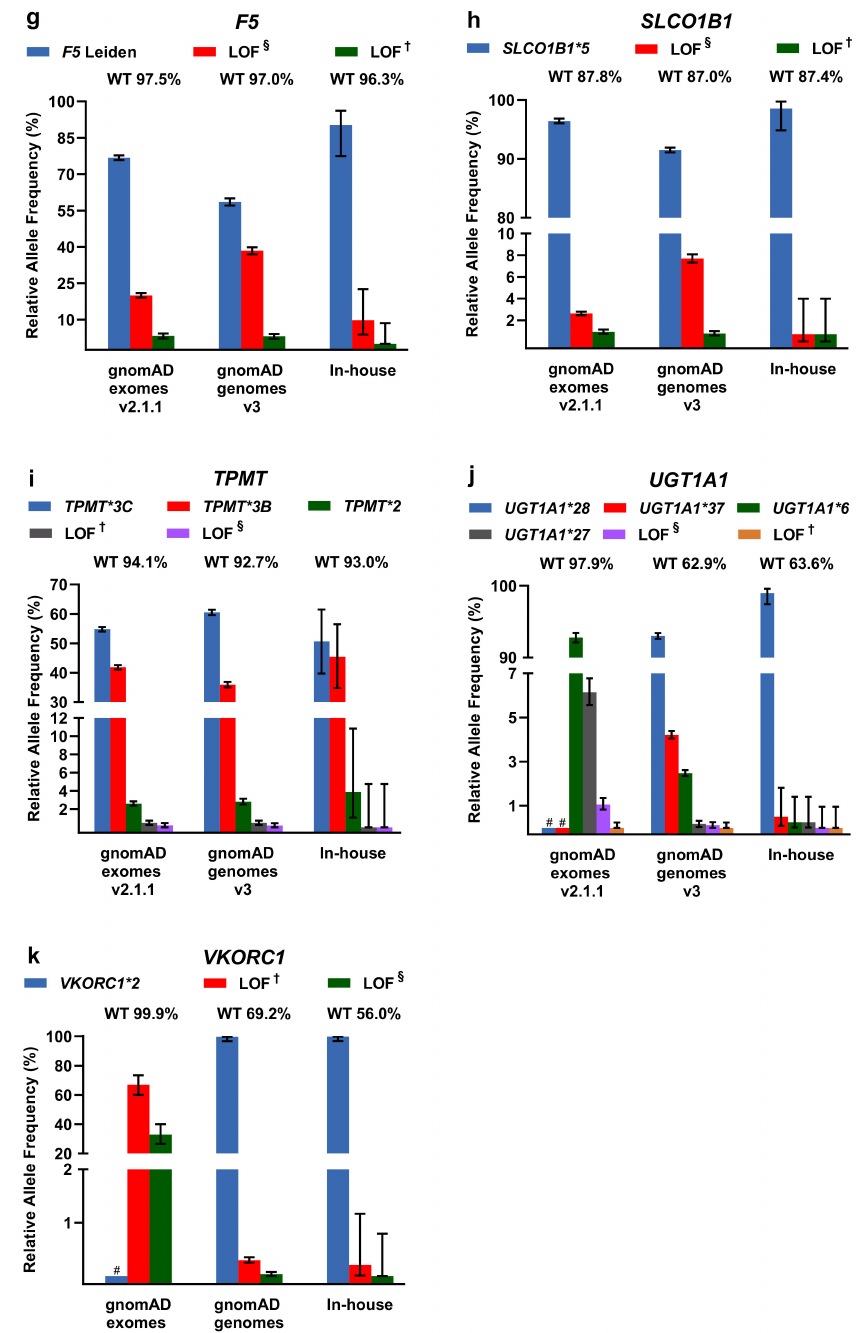
Figure 3. ( a – k ) Relative allele frequencies of pharmacogenetically-relevant variants in gnomAD exomes and genomes as well as in our in-house WGS cohort. The percentage of corresponding wildtype (WT) alleles is denoted. Note that wildtype status was inferred under the assumption that the listed variants detected in the same gene occur in trans and that no additional pharmacogenetically- relevant variant occurs at the wildtype allele. Note that some of the DPWG variants are not covered in gnomAD exomes (denoted with # in the graphs of CYP2C19*17 , CYP3A5*3 , UGT1A1*28 ,* 37 , and VKORC1*2 ). Error bars indicate 95% confidence intervals. † Loss-of-function (LOF) variants listed in HGMD, ClinVar, or PharmGKB. § LOF variants not listed in HGMD, ClinVar, or PharmGKB in the context of drug